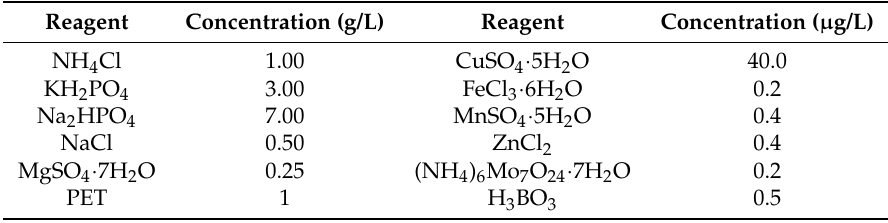
Table 1. Culture composition of bacteria F4.